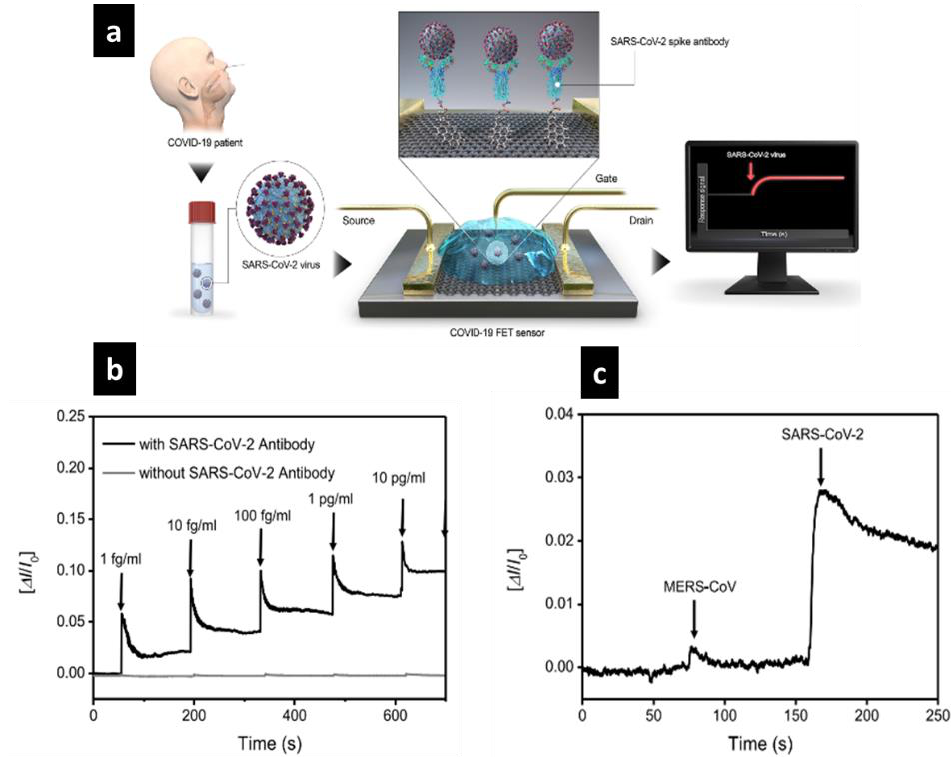
Figure 8. ( a ) Schematic illustration of graphene-based field e ff ect transistor (FET) biosensor mechanism and detection, where SARS-CoV-2 (spheres) binds to antibodies (Y-shapes). ( b ) Real-time response of COVID-19 FET toward SARS-CoV-2 spike protein. ( c ) Bionanosensor selectivity response toward two di ff erent proteins: SARS-CoV-2 and MERS-CoV. Reprinted from Seo et al. [69]. Copyright 2020 American Chemical Society.